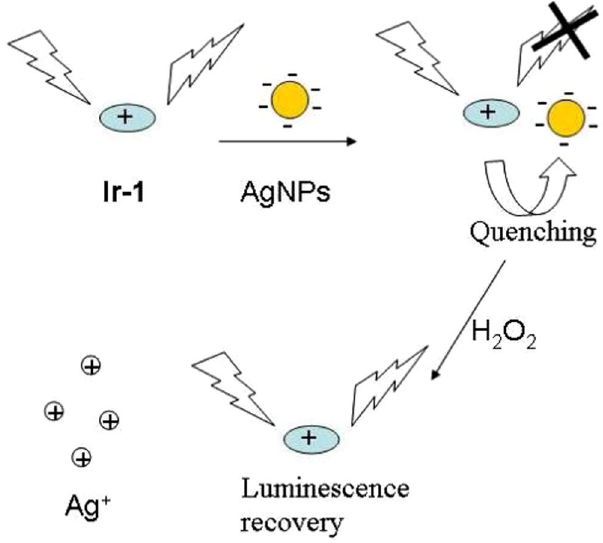
Figure 1. Illustration of the design rationale for the detection of H 2 O 2 using a luminescence sensor based on Ir-1 –AgNPs system.